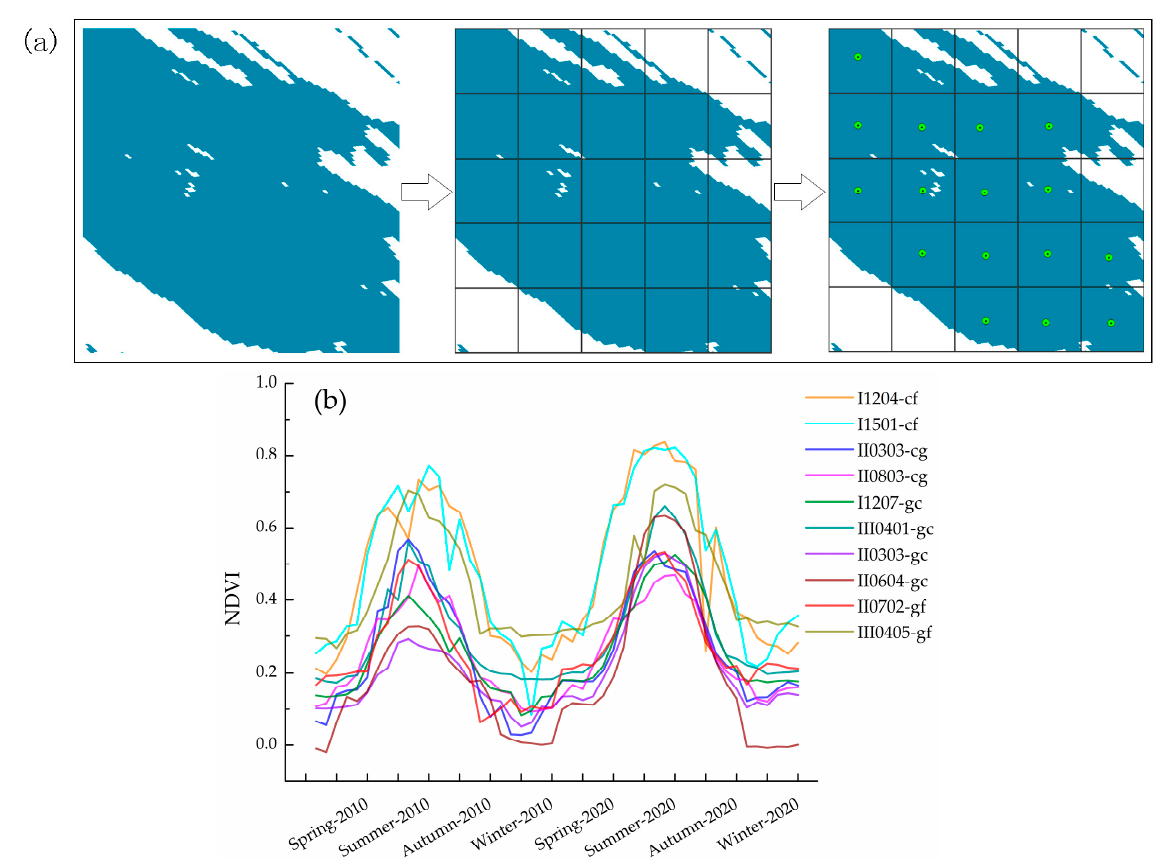
Figure 6. ( a ) Example of ~500 m grid based on 30 m pixel reference map; ( b ) features of NDVI in different subecoregions.